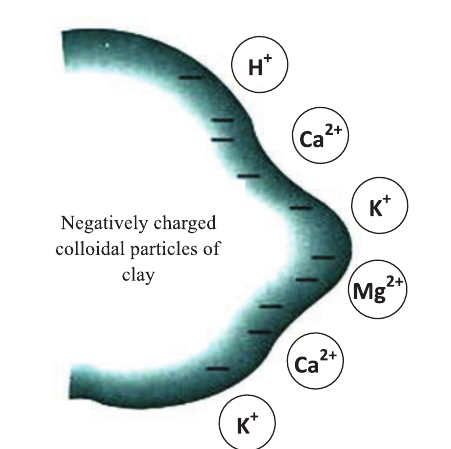
Fig. 2. Absorptive barrier of heavy metals in roadside